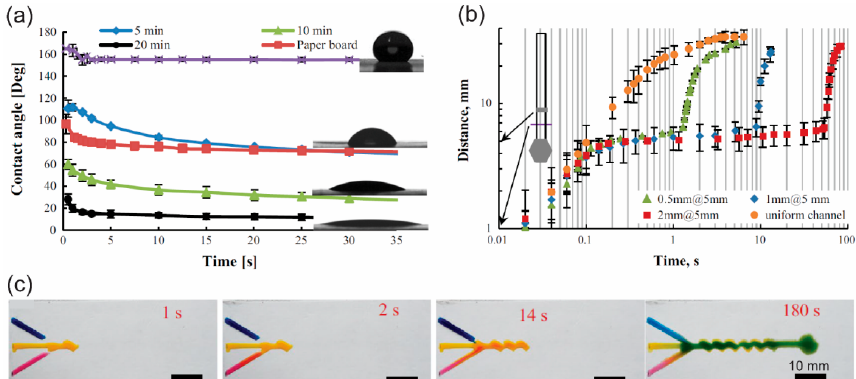
Figure 12. Delay of the fluid flow in a p-CFM device by using absorbent pads. ( a ) Schematics of the flow of fluid in a paper channel modified with an absorbent pad, and ( b ) images of fluid’s travel in paper channels modified with absorbent pads of various lengths. ( c ) Flow distance versus square root of the time the fluid is flowing through paper channels modified with absorbent pads of various lengths. Reprinted with permission from the authors of [88]. Copyright 2013 American Chemical Society.